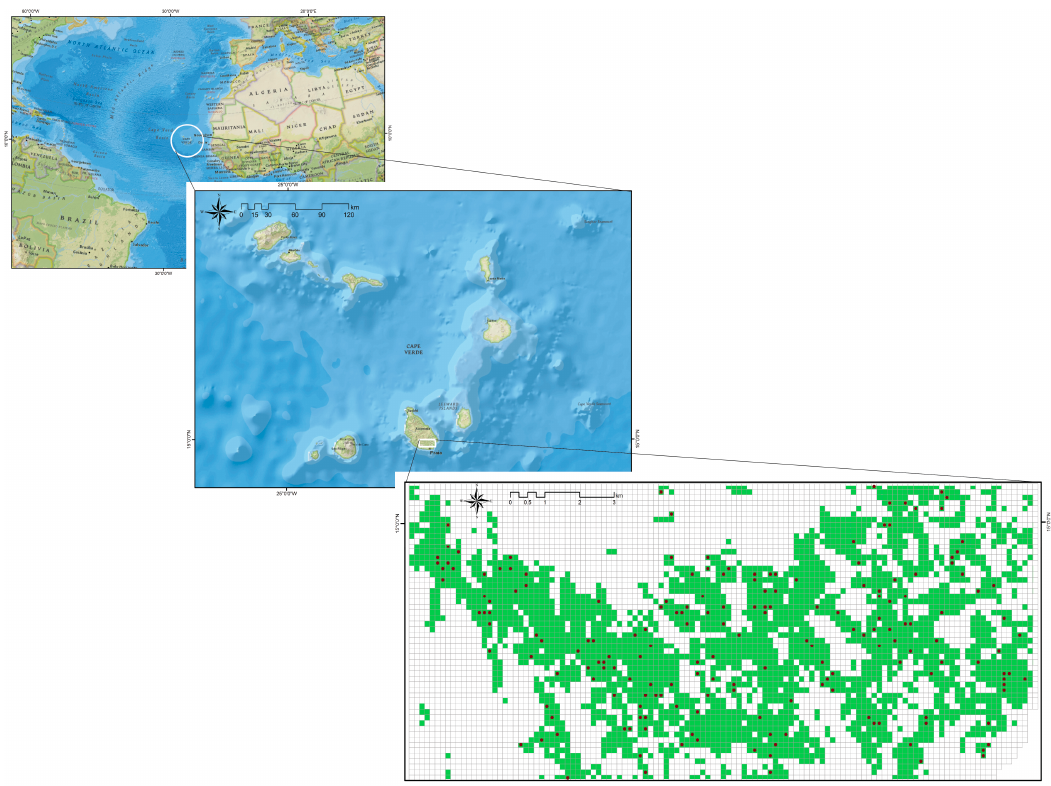
Figure 1. Location of the study area in the Cape Verde archipelago. On the bottom right the forest map in green with the location of the field plots.